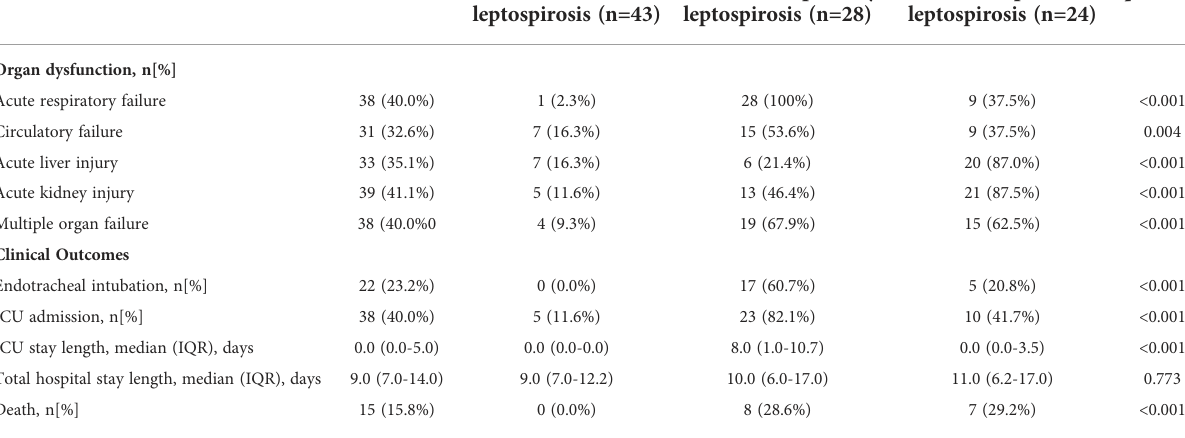
TABLE 3 Organ dysfunction and outcomes of different